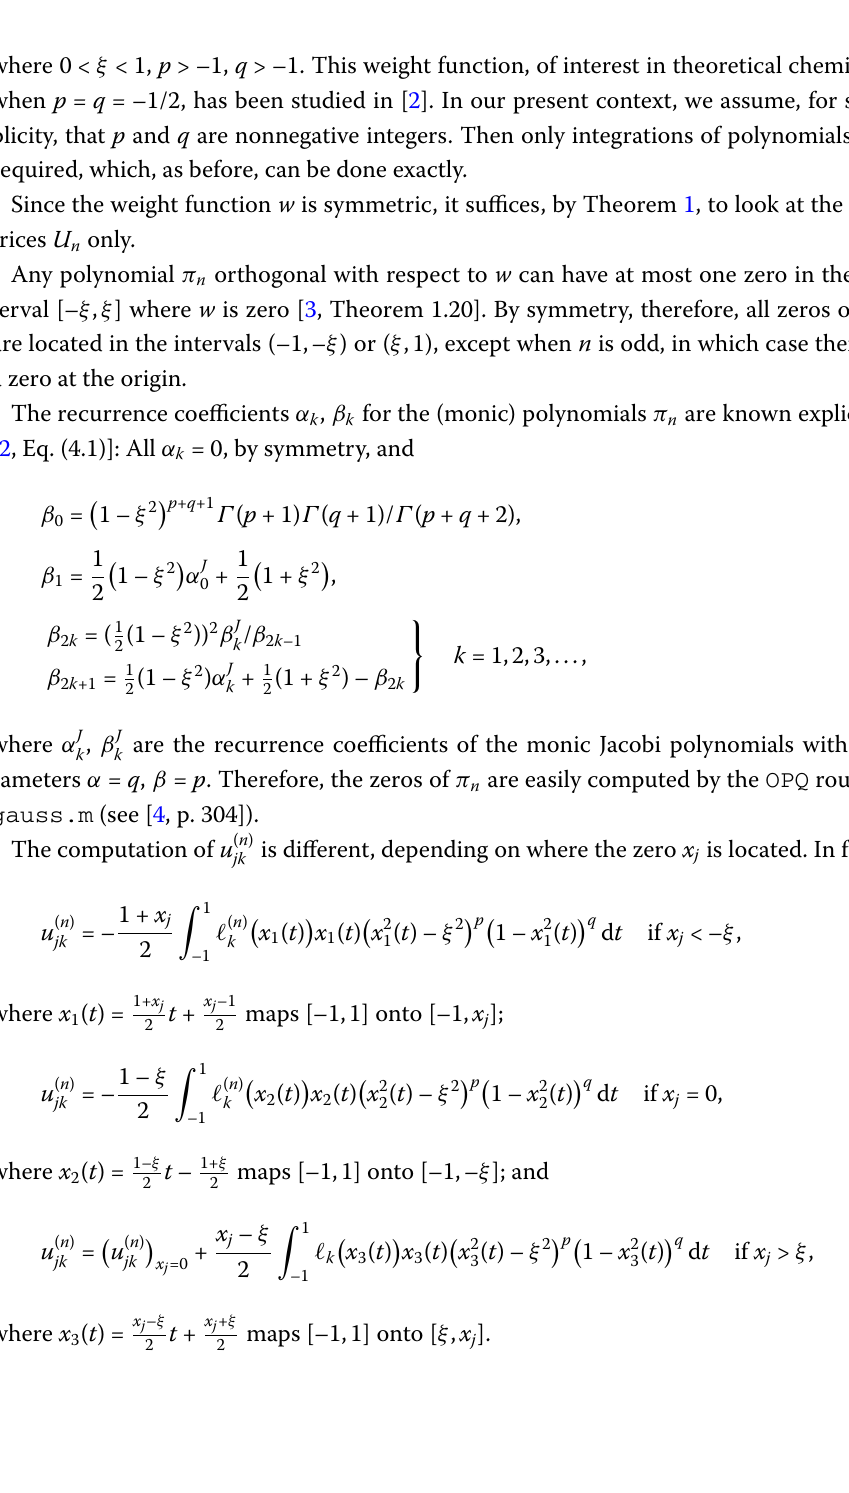
Figure 14 Eigenvalues of U n in the case of the Hermite weight function for n = 5,15,30 (from left to